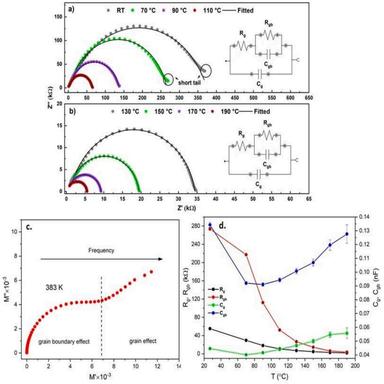
Nyquist plot of LNMO for a) RT-110 ◦C, b) 130–190 ◦C with the equivalent circuit (inset diagram), c) the complex modulus plot of LNMO at 110 ◦C, and d) The equivalent circuit fitted parameters (Rg, Rgb, Cg and Cgb) for circuit element at all temperatures.